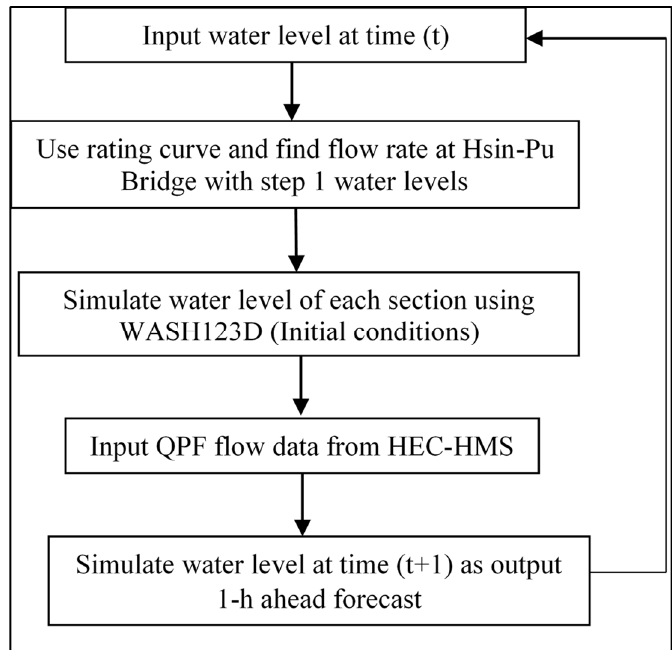
Figure 4. Conceptualization of the study area for model application, zones (A and B) in HEC-HMS and zone C in WASH123D ( a ) Mesh construction from radar grid points ( b ) grid constructions of WAH123D [13].